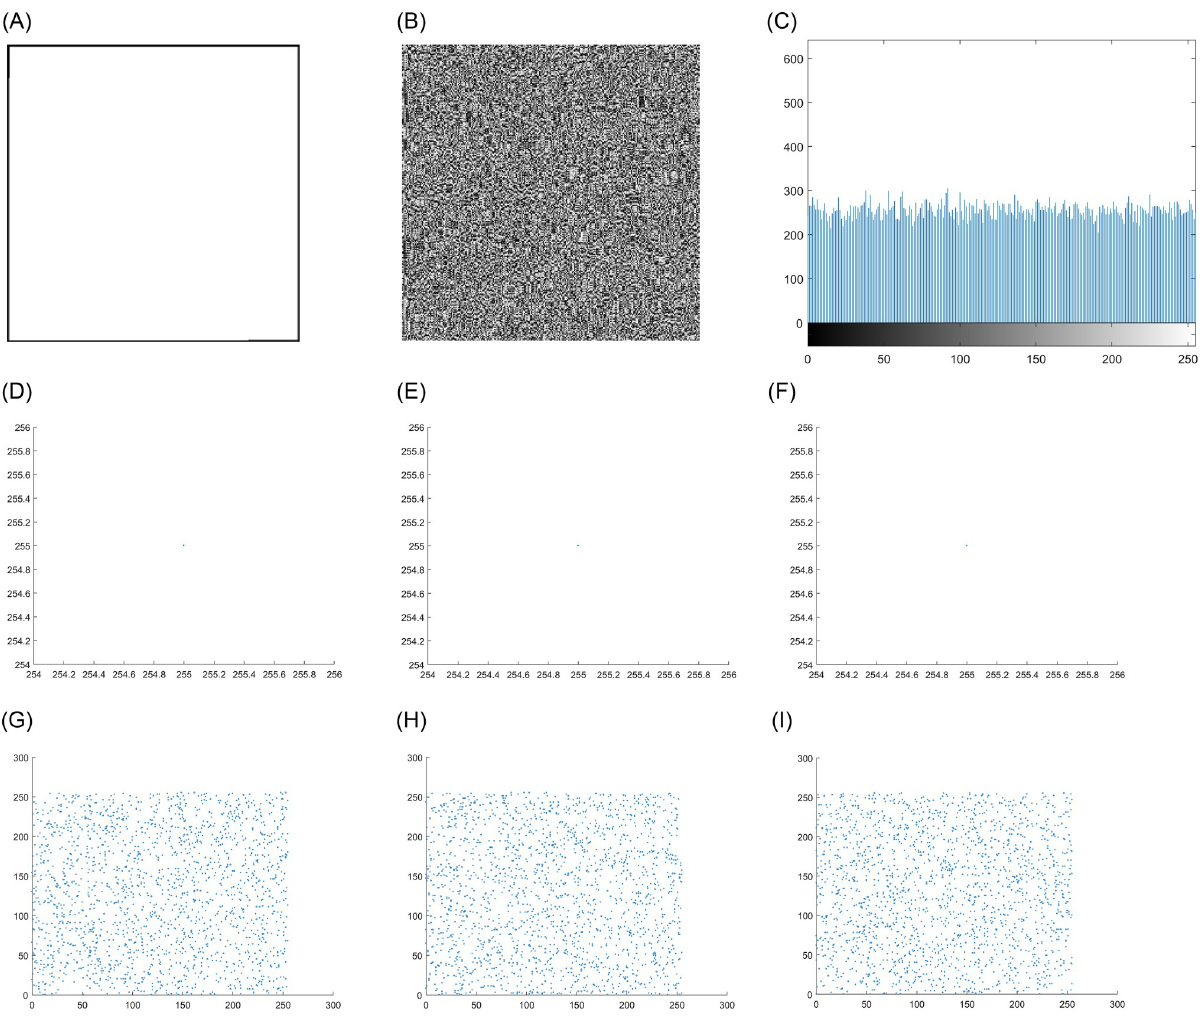
Fig 12. Analysis of encryption test results of all white images. A: Original full white image. B: Encrypted full white image. C: Histogram pixel of encrypted image. D: Horizontal pixel of original image. E: Vertical pixel of original image. F: Diagonal pixel of original image. G: Horizontal pixel of encrypted image. H: Vertical pixel of encrypted image. I: Diagonal pixel of encrypted image.